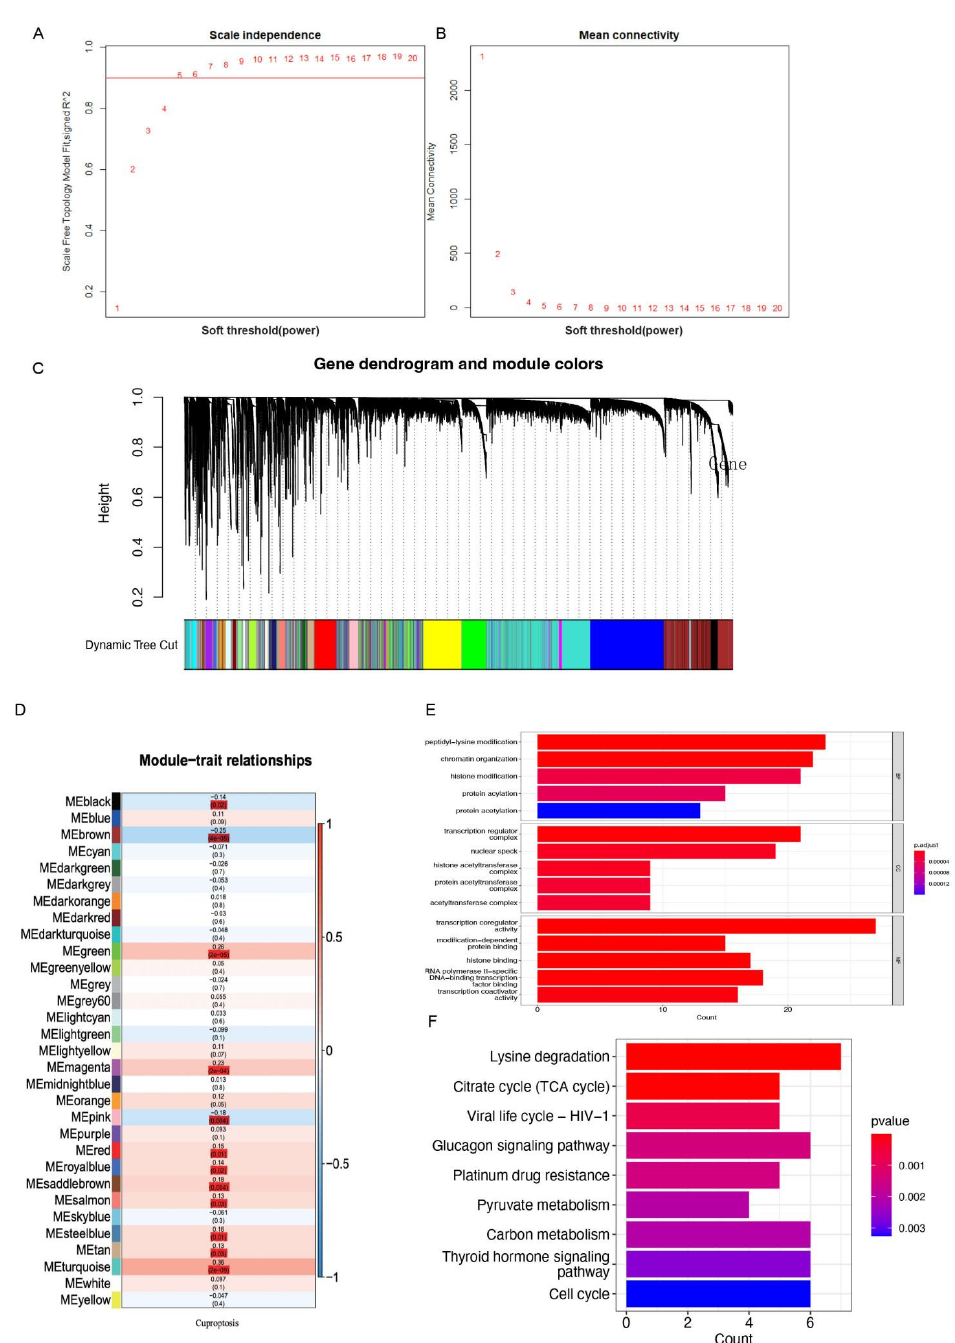
Figure 1. WGCNA revealed potential mechanisms and pathway enrichment analysis of CRGs in STS patients. ( A , B ) The distribution and tendency of scale-free topology model fit and mean connectivity accompanied by a soft threshold. ( C ) A dynamic tree cut was merged with a dynamic method to decipher the clustering of genes among different modules. ( D ) The mean correlations between module and cuproptosis. The colors of the cells represent associated intensity, and the numbers in parentheses represent the p value of the correlation test. ( E ) the enriched item in the gene ontology analysis; ( F ) the enriched item in the Kyoto Encyclopedia of Genes and Genomes analysis. The size of the circles represents the number of enriched genes. BP: biological process; CC: cellular component; MF: molecular function; and CRG: cuproptosis-related